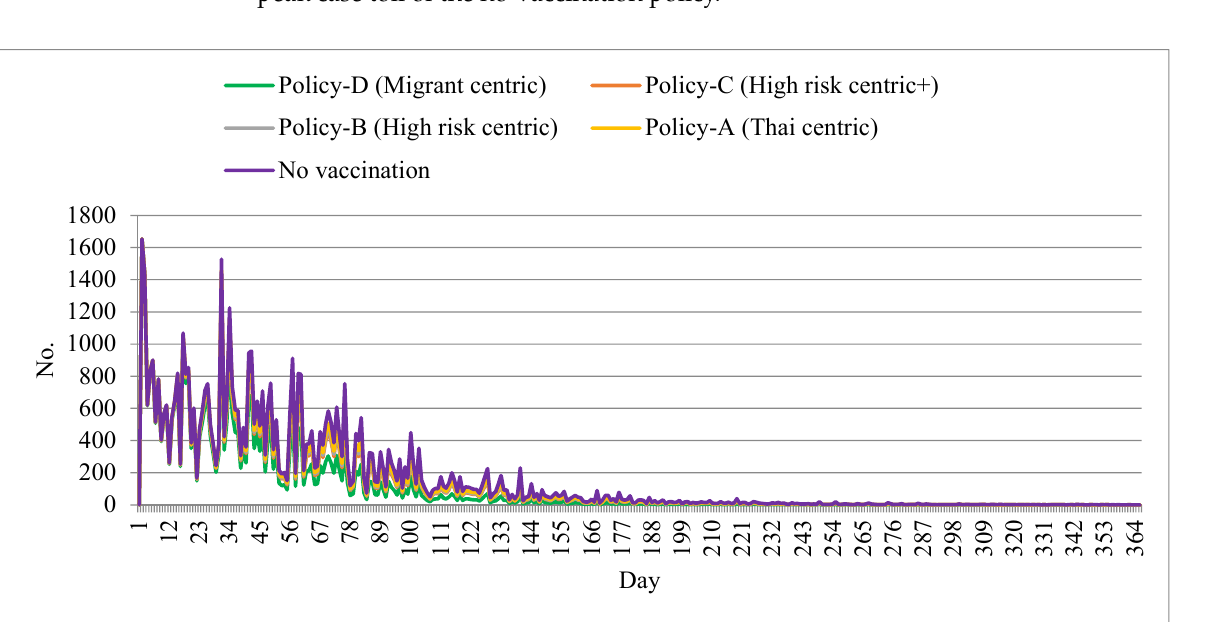
Figure 2. Daily new cases by different policy scenarios.